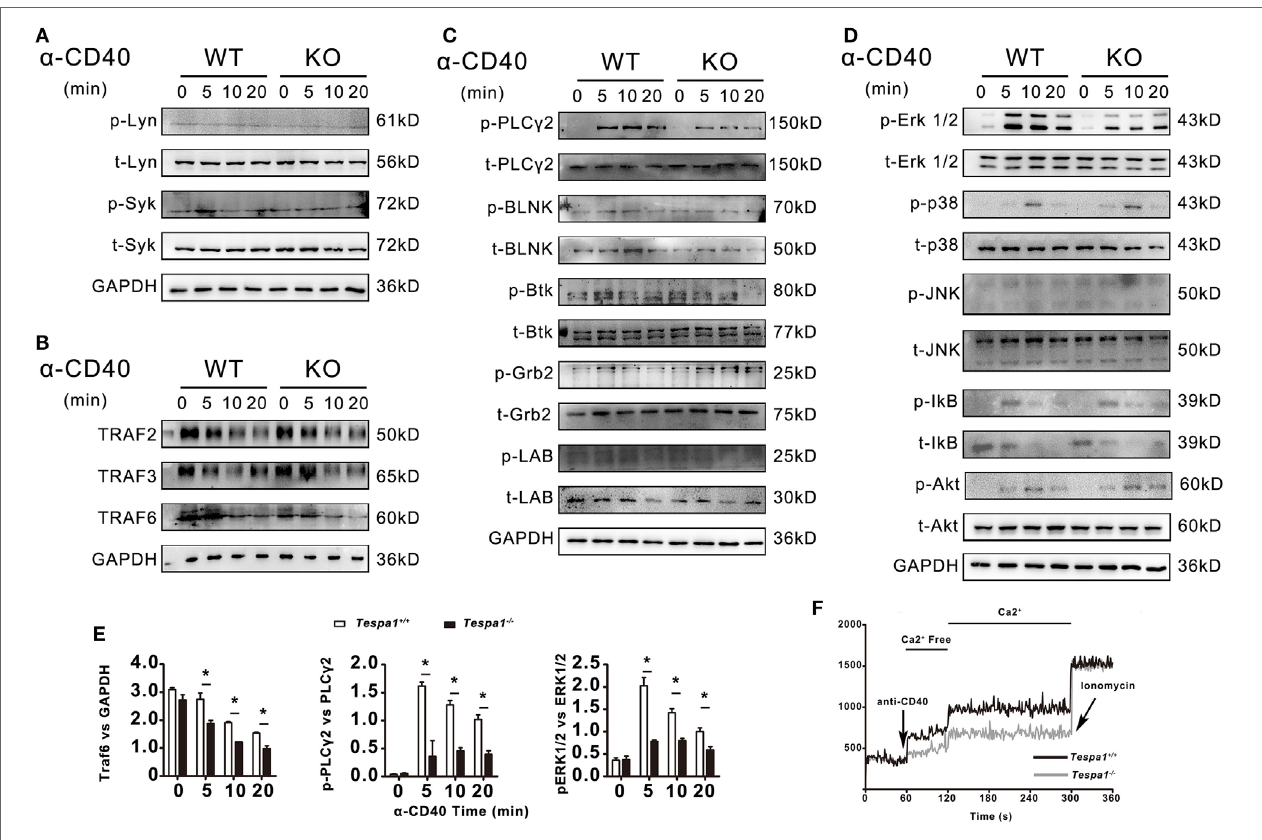
FigUre 5 | B-cell receptor and CD40-mediated cell signaling in Tespa1 -deficient and wild-type (WT) B cells. (a) Levels of total and phosphorylated Lyn and Syk. (B) Levels of TNFR-associated factor (TRAF) 2, TRAF 3, and TRAF 6. (c) Levels of total and phosphorylated PLC γ 2, BLNK, Btk, Grb2, and LAB. (D) Levels of total and phosphorylated Erk, p38, Jnk, Ikb, and Akt were measured by immunoblot. (e) TRAF 6 was normalized to GAPDH, Phospho-Plc γ 2 and Phospho-ERK1/2 was normalized to total Plc γ 2, and total ERK1/2 by densitometry statistical analysis. (F) Calcium flux was measured at the indicated times after stimulation. Data are from one experiment representative of three